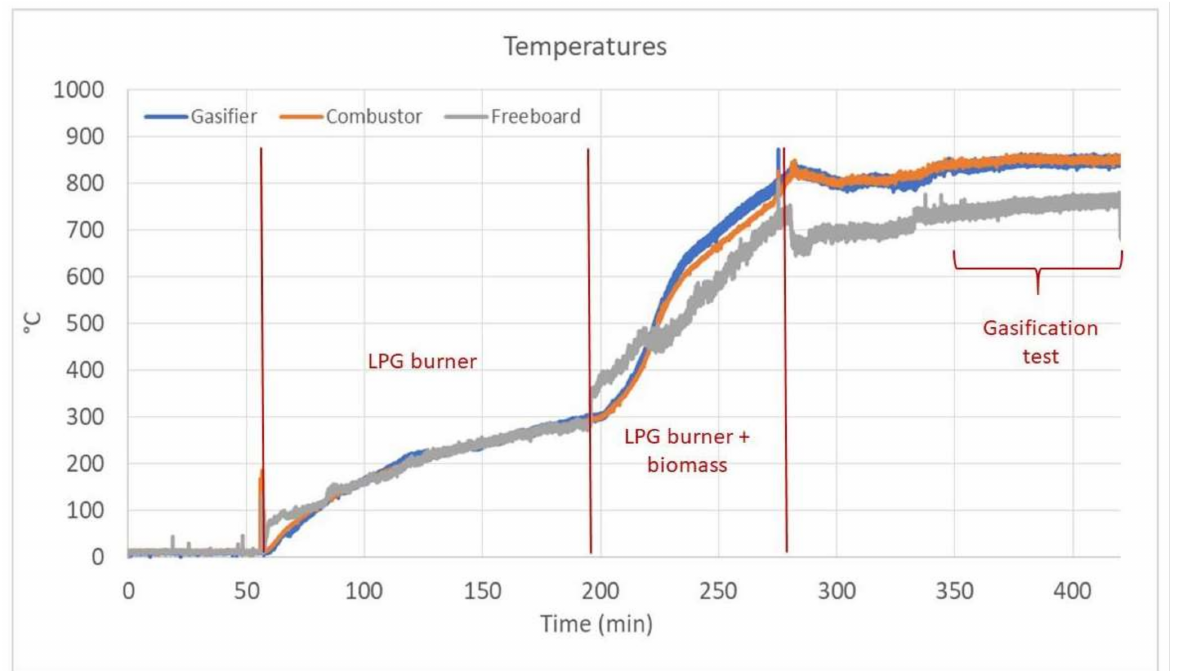
Figure 5. Temperature values measured during the start-up phase and during the gasification